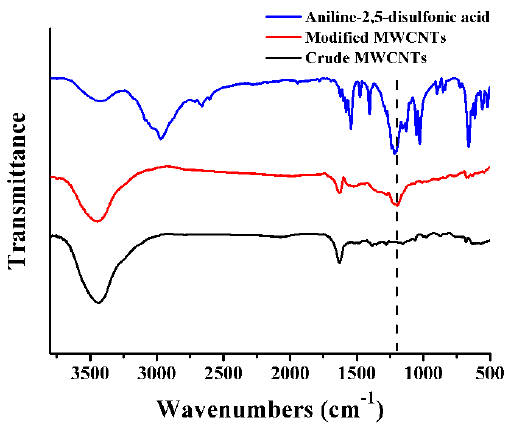
Figure 1. Fourier transform infrared (FT-IR) spectra of the crude and modified multi-walled carbon nanotubes (MWCNTs).